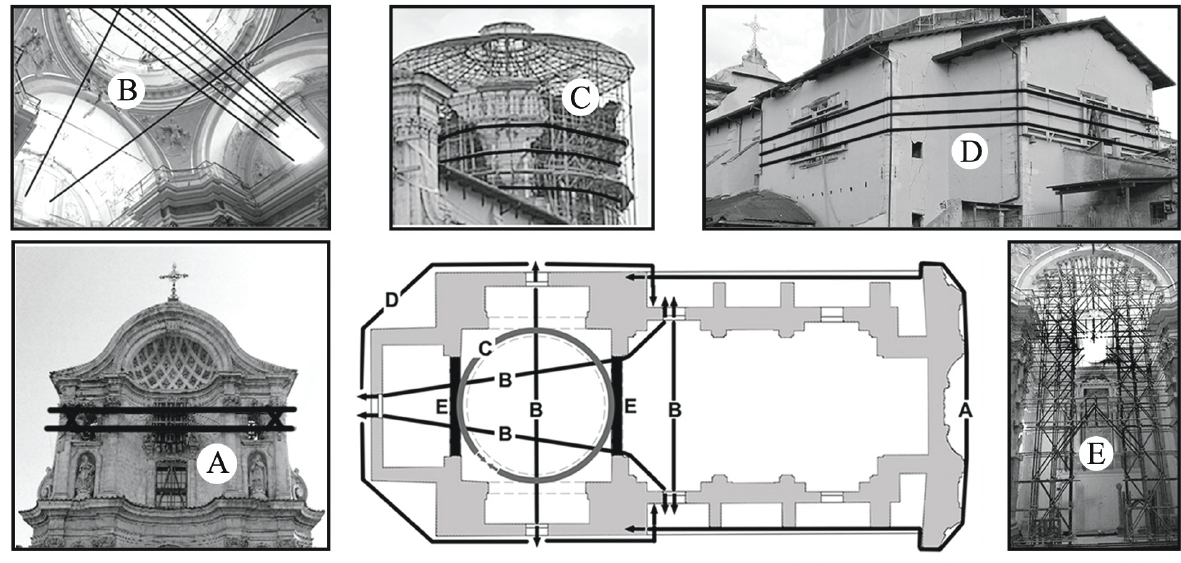
Figure 2. General scheme of the safety measures; linear ties for façade (A) and for transept-nave-apse walls (B and D); scaffold and confine- ment for tambour (C); scaffolds for apse arch and transept-nave arch